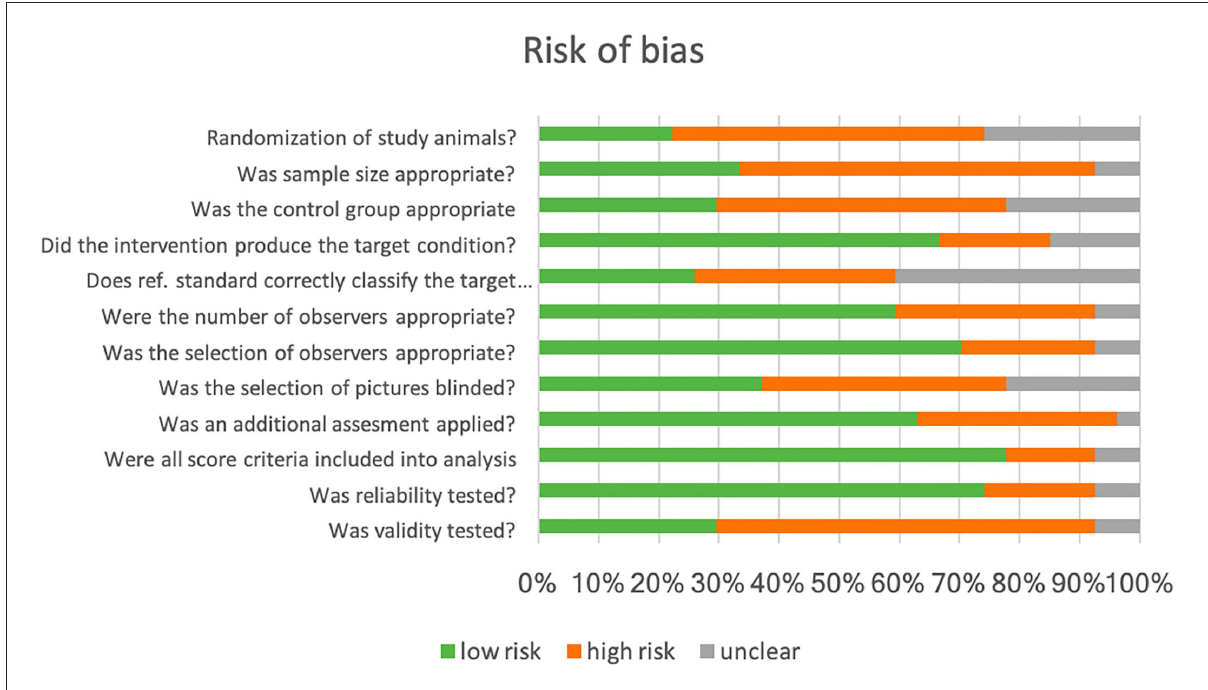
FIGURE3 Bar chart for the percentage of studies with a specific (high, low, and uncertain) risk of the bias according to the (adapted) checklist for Quality Assessment of Diagnostic Accuracy Studies (QUADAS) (33).